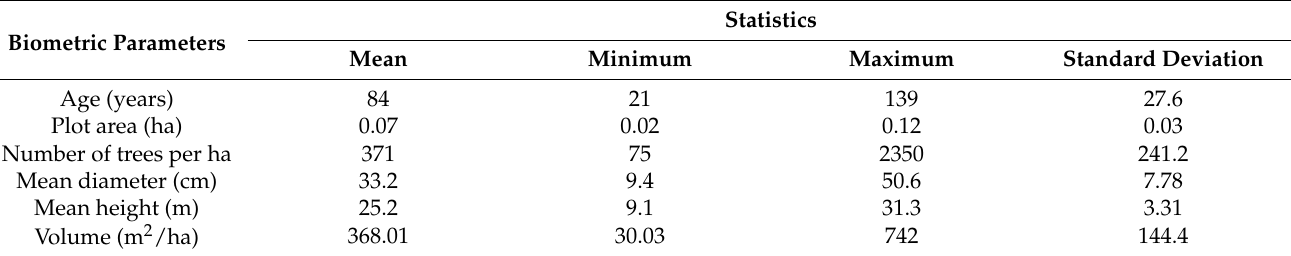
Table 1. Summary statistics of sample plot characteristics.